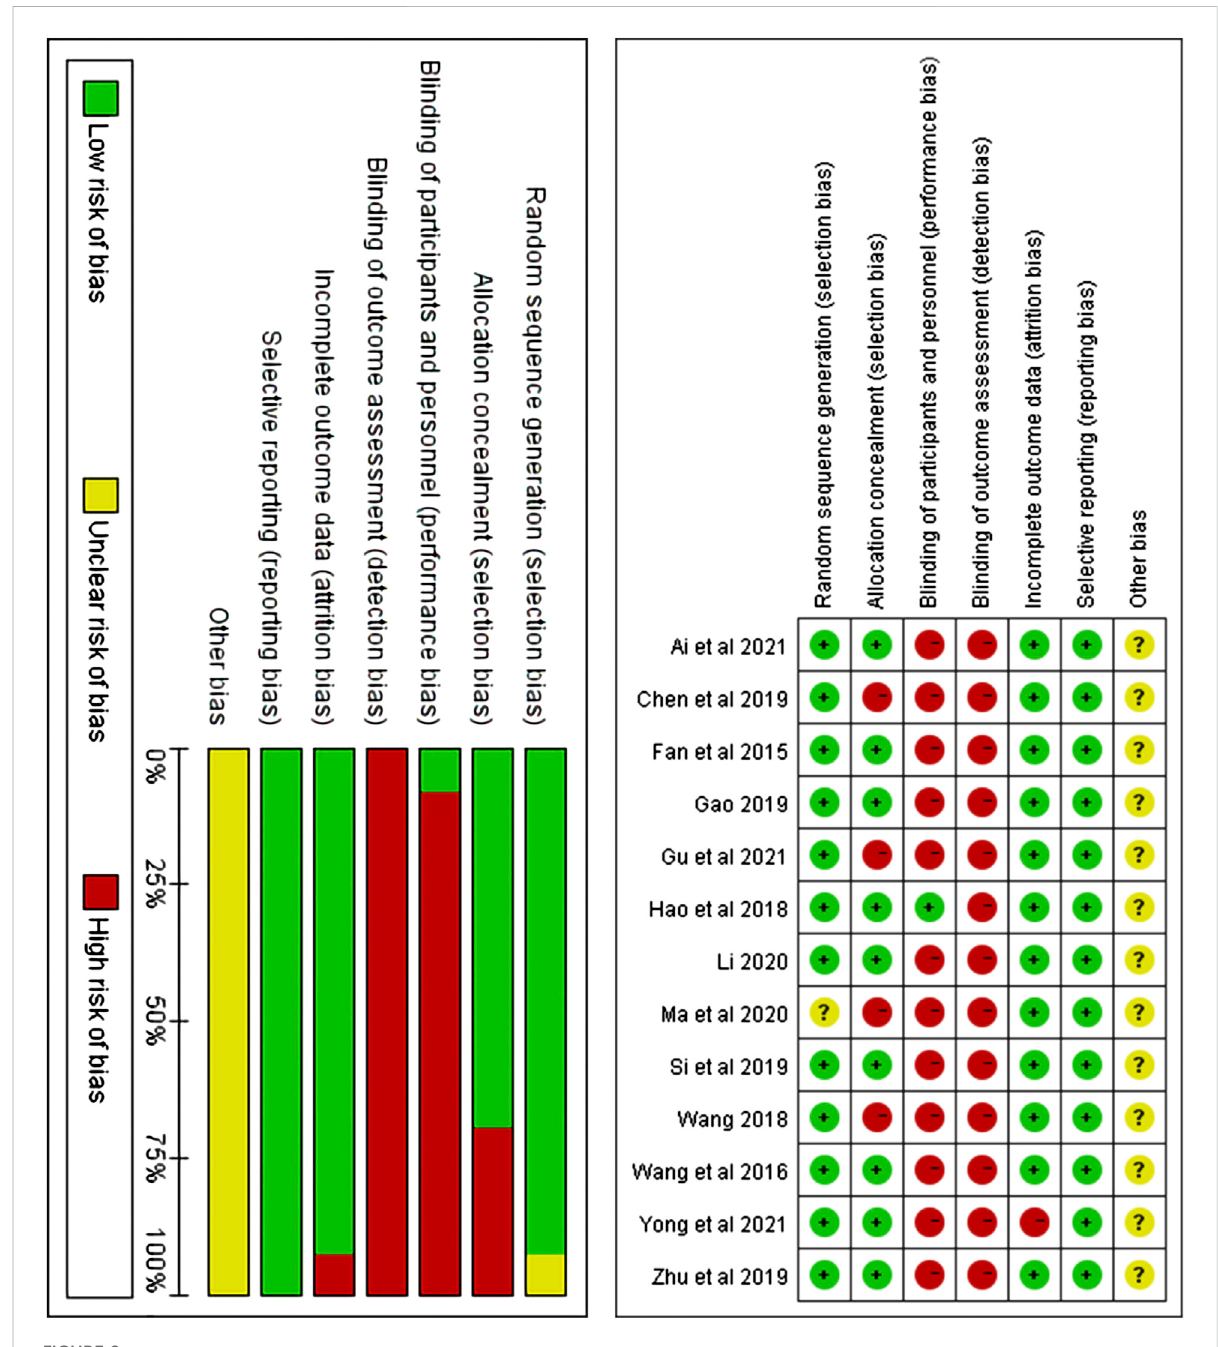
FIGURE 2 Risk of bias assessment graph for included RCTs and distribution of risk of bias of included